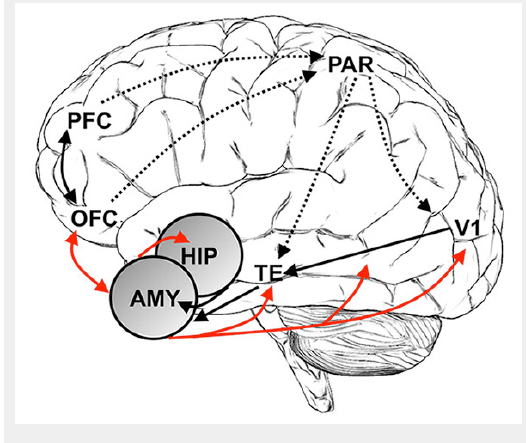
Schematic illustration of brain areas involved in selected cognition- emotion interactions. The amygdala (AMY) has widespread reciprocal connections with many cortical regions, including perceptual pathways (primary visual cortex, V1, inferior temporal cortex, TE), memory-related regions (hippocampus, HIP), and prefrontal regions (orbitofrontal cortex, OFC, prefrontal cortex, PFC). This connectivity enables the amygdala to receive rich sensory information and to strengthen the neural representation of emotional stimuli via feedback to sensory pathways, attention- related regions (PFC and parietal lobe, PAR), and memory regions. In addition, multiple connections to prefrontal areas relay amygdala input to regions involved in more deliberate forms of